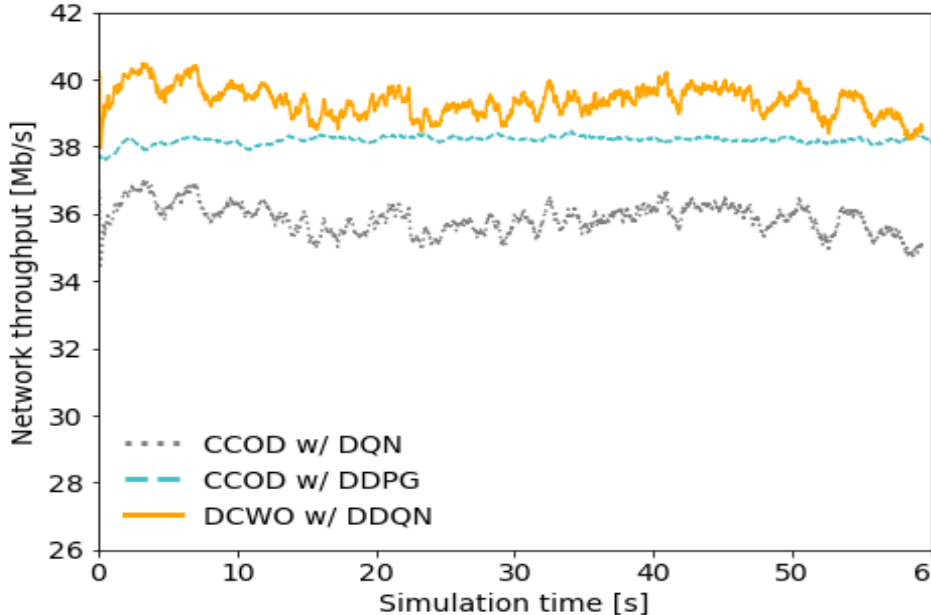
Figure 6. Instantaneous Network Throughput for Dynamic Scenario.